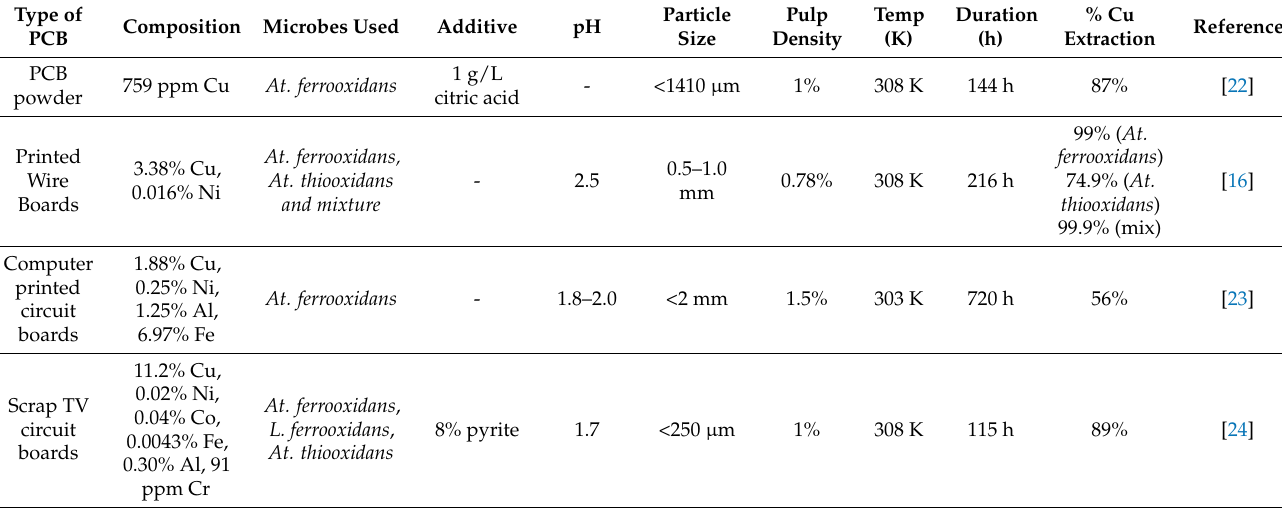
Table 1. Comparison of previous work on copper bioleaching from printed circuit boards (PCBs) using lithoautotrophic and/or heterotrophic